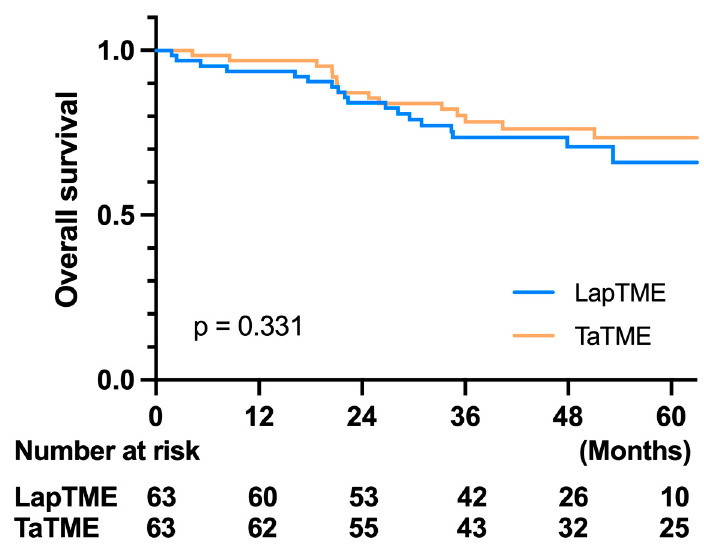
Figure 2. Kaplan–Meier survival curves of OS between the TaTME and LapTME group.